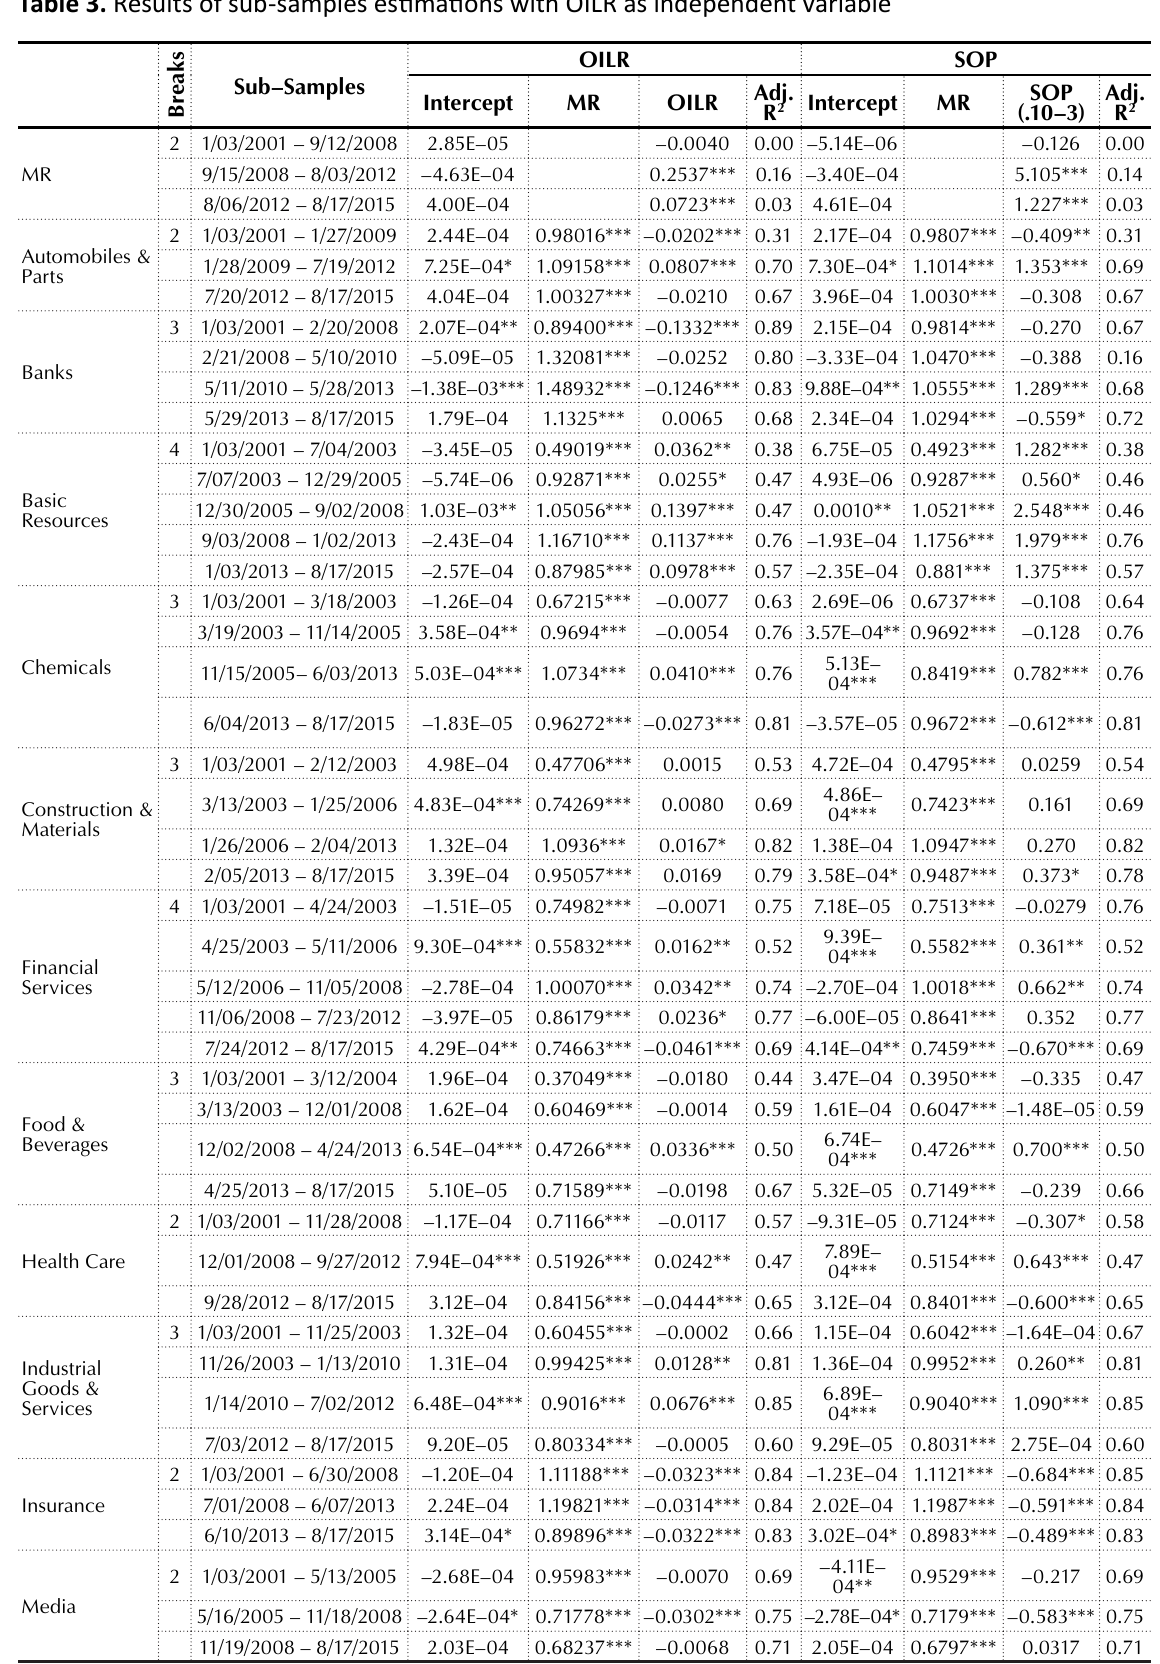
Table 3. Results of sub-samples estimations with OILR as independent